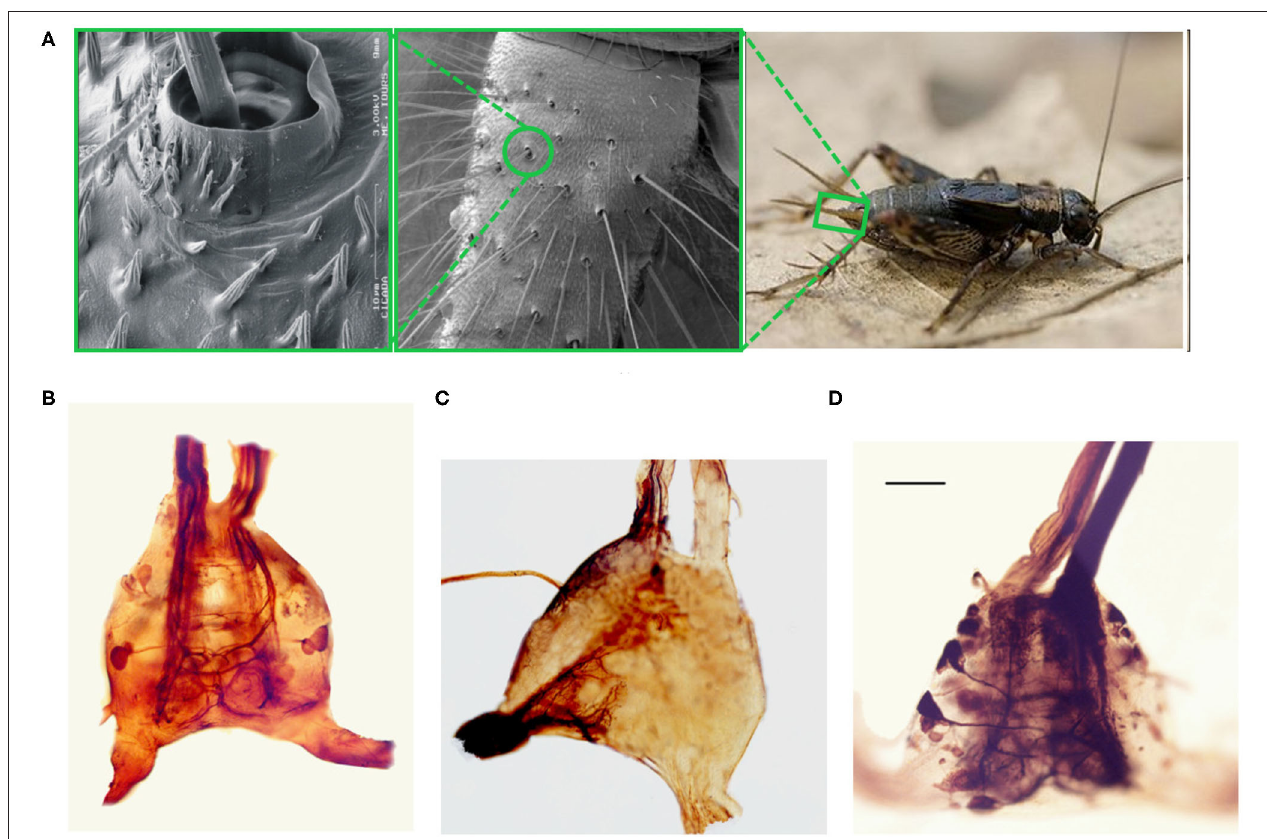
FIGURE 1 | Optical and scanning electron microscopy images of the cricket and its terminal abdominal ganglion. (A) Three panel image showing different extents of zoom of the cricket cercal hairs. (Right) An image of a wood cricket. A green rectangle highlights the base of its right cercal appendage. (Center) a scanning electron microscopy image of the base of a crickets cercus. A green circle highlights one of the sockets within which cercal hairs pivot. (Left) A scanning electron microscopy image of a cercal hair embedded within a socket. (B) An optical microscopy image of an isolated terminal abdominal ganglion. The two extensions at the base of the image correspond to the cercal nerves, where the sensory neuron axons from the hair receptors on the two cerci project into the ganglion. The two vertical extensions at the top of the image are the two axon bundles composing the nerve chord that ascends up to higher ganglia. (C) An image of the TAG where cobalt chloride dye, appearing almost black in high concentrations, has been used to stain the afferents projecting from the left cercus into the ganglion. (D) An image of the TAG where dye has been used to stain the cell bodies, dendrites, and the axonal projections up the nerve chord, of a subset of giant